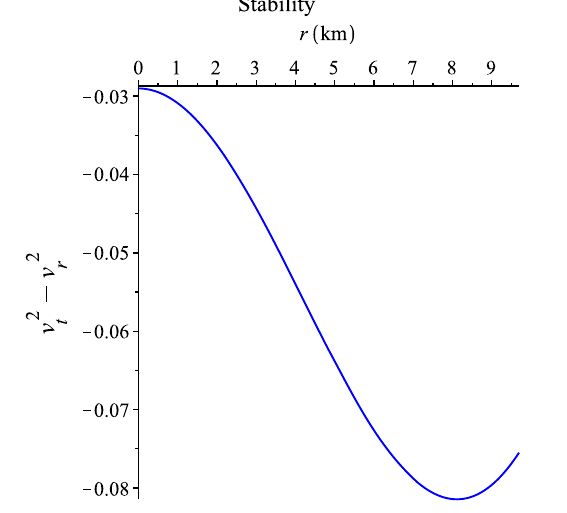
Fig. 8 Plot of the v 2 t − v 2 r for the parameter values used in Fig. 1